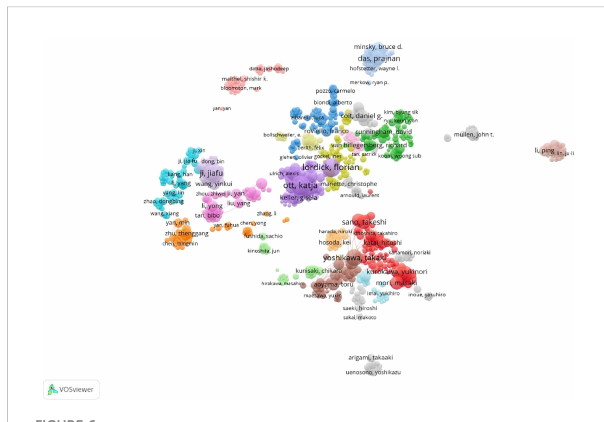
FIGURE 6 Density map of the co-cited authors, who published literature related to neoadjuvant chemotherapy for GC from 1991 to